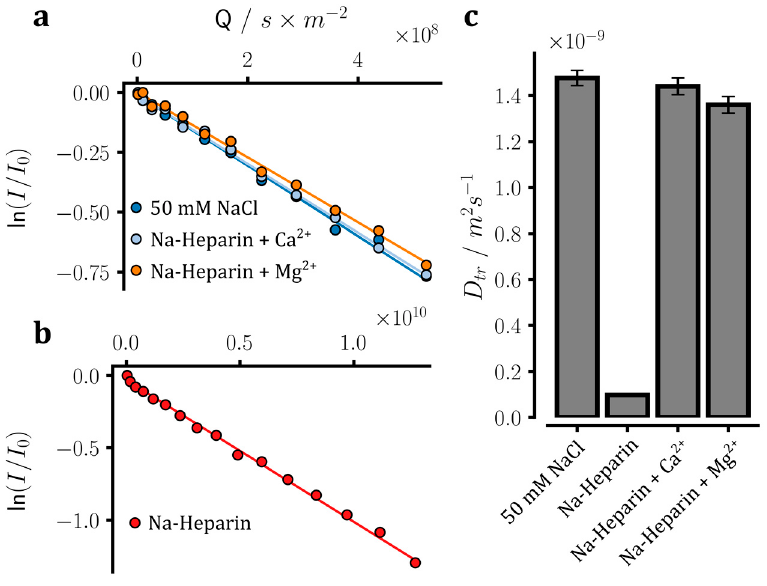
Figure 5. Translational diffusion of sodium ions measured in heparin samples through 23 Na or 1 H-based pulse field gradient NMR diffusion experiments. ( a , b ) Gradient-dependent decrease in the intensity of 23 Na NMR signals in sodium heparin samples in the presence of 100 mM CaCl 2 or MgCl 2 , as well as in the reference NaCl sample. Due to the fast relaxation of 23 Na signals in the sodium heparin sample without added ions and the severe loss of 23 Na signal intensity, no 23 Na NMR diffusion experiment could be conducted for this sample. Instead, as shown in ( b ), the diffusion coefficient of sodium ions in the heparin-bound form was estimated through a 1 H-based NMR diffusion experiment, assuming that the heparin molecules and sodium ions are rigidly bound and diffuse together. ( c ) The obtained translational diffusion coefficients ( D tr ) of sodium ions in the measured samples. The diffusion data are consistent with the partial release of sodium ions from heparin after the addition of Mg 2+ and especially Ca 2+ ions.